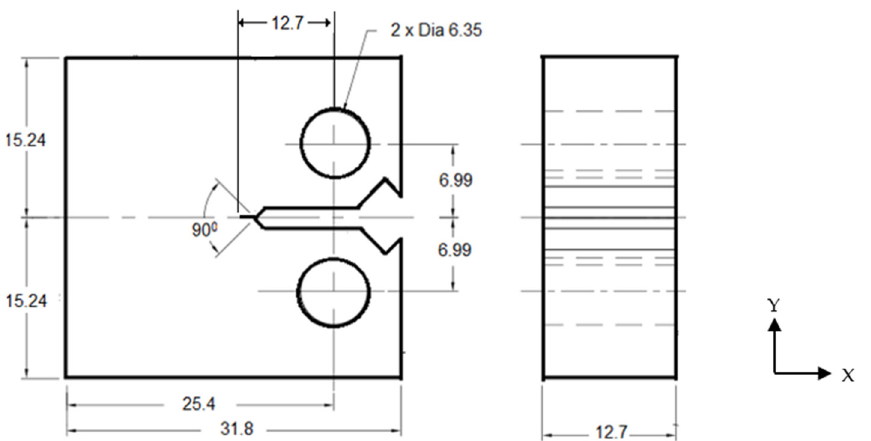
Figure 2. Compact Tension (C(T)) Specimen. All dimensions are in